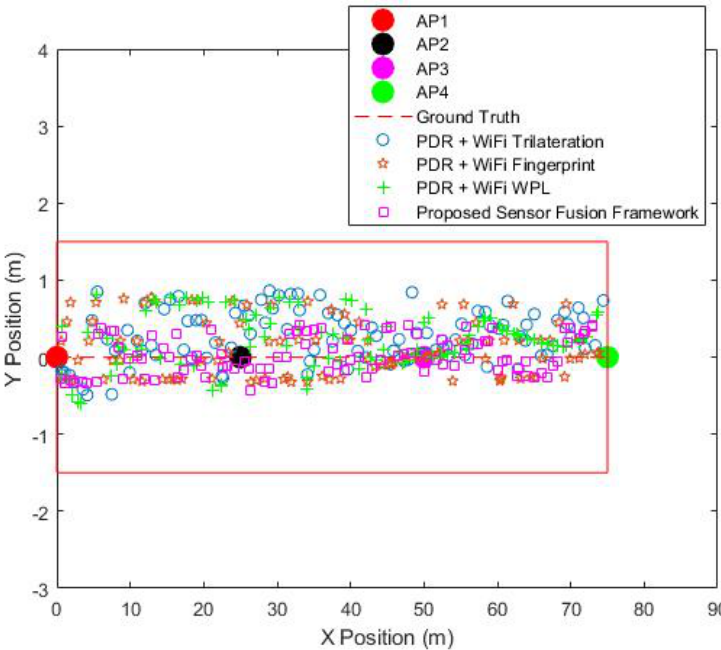
Figure 8. Trajectories of ground truth, proposed sensor fusion framework, conventional sensor fusion frameworks from linear